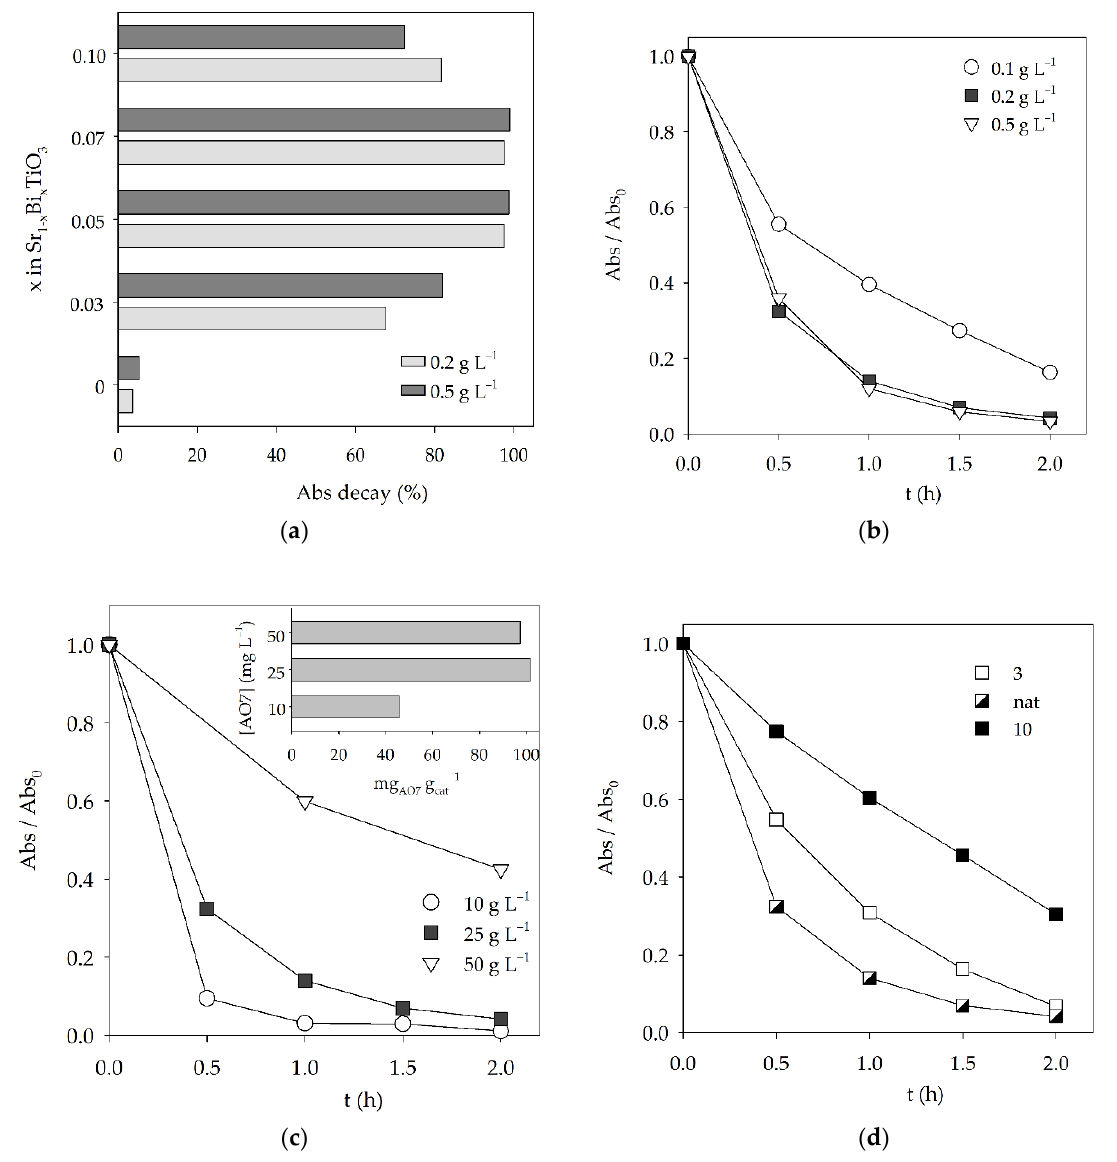
Figure 3. Influence of ( a ) Bi doping on the relative Abs 484 nm decay after 1 h (C i AO7 = 10 mg L −1 , at two catalyst doses); ( b ) catalyst dose; ( c ) initial dye concentration (inset mg AO7 removed/g of catalyst, for the tested dye concentrations); ( d ) pH on the relative absorbance decays, measured at 484 nm, for the photocatalytic degradation of AO7, with the Sr 0.95 Bi 0.05 TiO 3 perovskite under visible light.